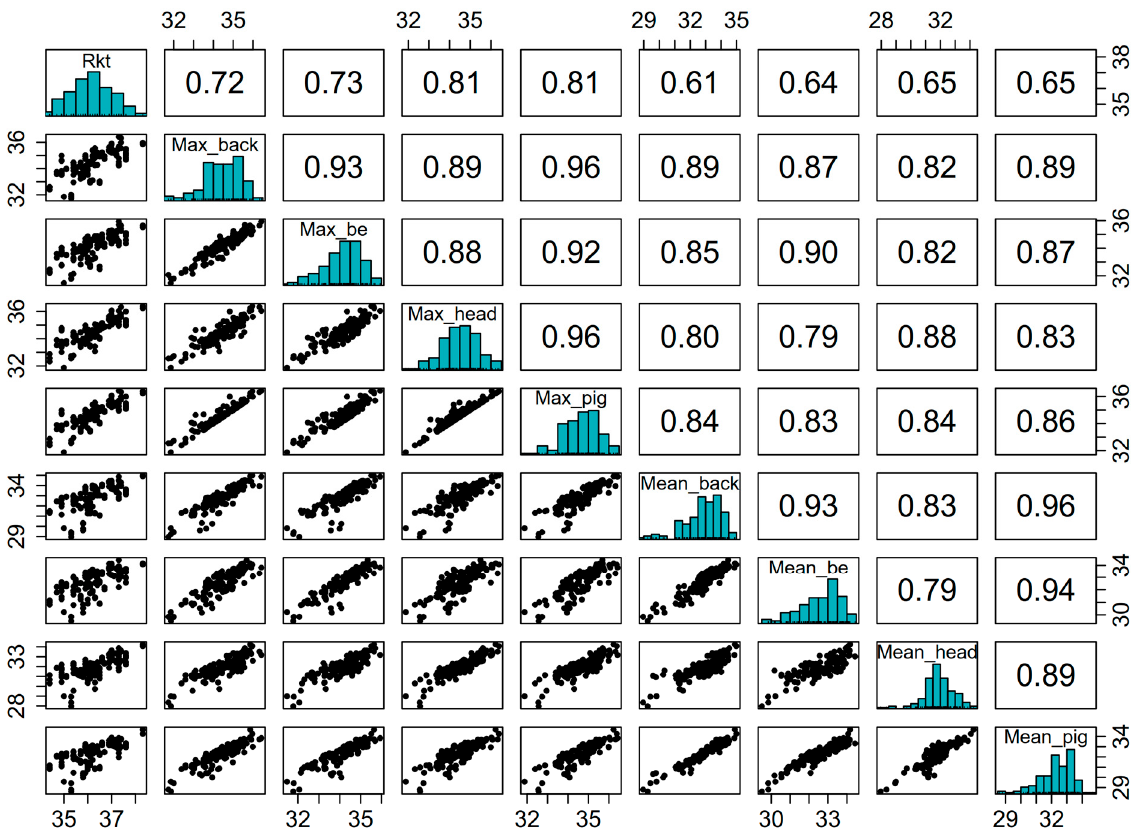
Figure 4. Pearson correlations of the rectal temperature (Rkt) and the body parts (mean and max) (upper right), and a histogram (diagonal) and scatterplot (bottom left) of the body parts. All captions are in °C.